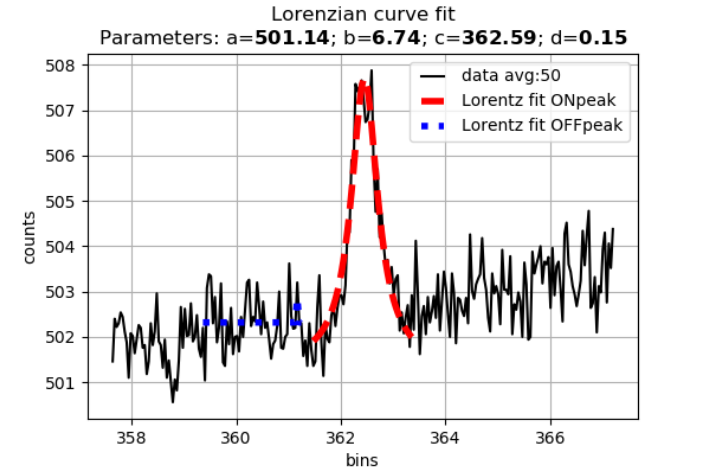
Figure 2. Peak fitting with a Lorentzian curve in a region where a peak is present (red) and where no peaks are present (blue). Parameters (a = 501.14, b = 6.74, c = 362.59, d = 0.15) refer to the red